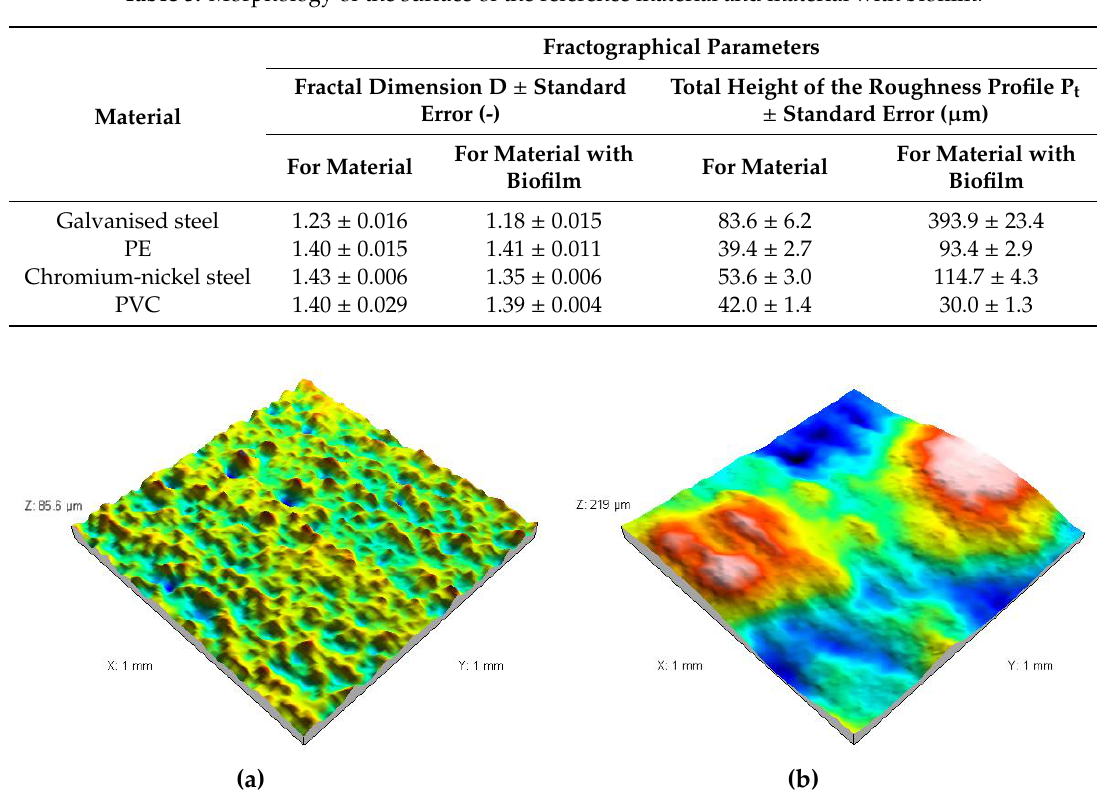
Table 5. Morphology of the surface of the reference material and material with biofilm.